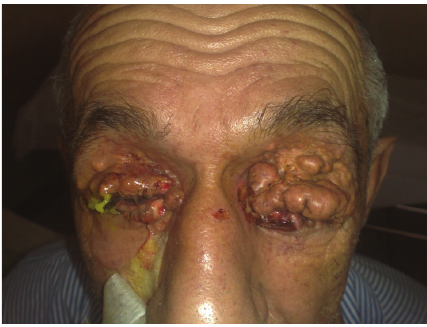
Figure 5: Involvement of nasal mucosa.